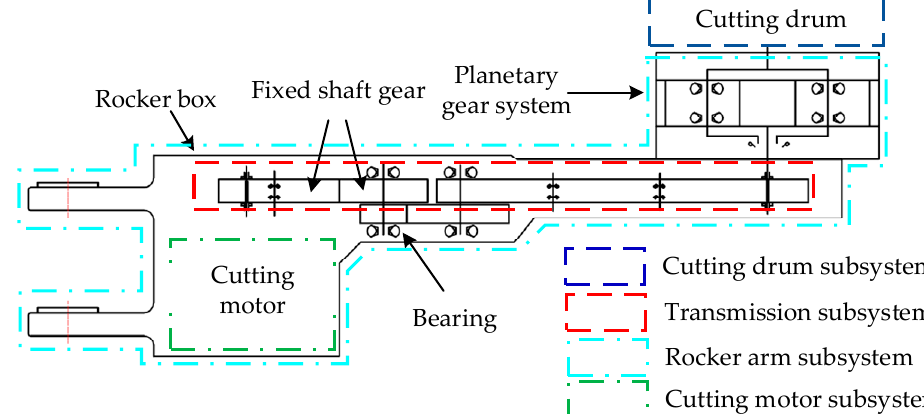
Figure 2. The structure of the shearer-cutting units.